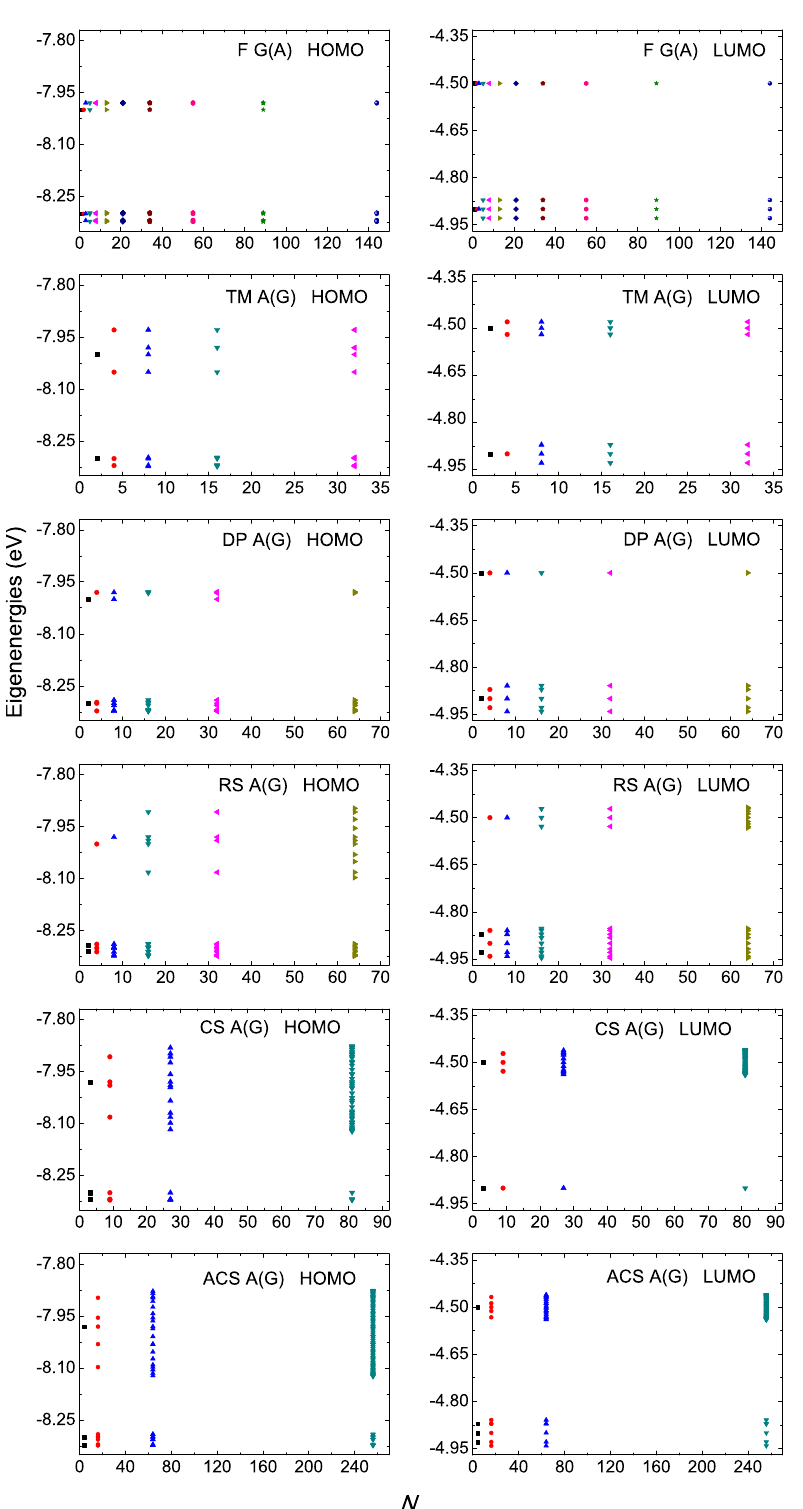
Figure 2. Eigenspectra of F A(G), TM A(G), DP A(G), RS A(G), CS A(G), ACS A(G) polymers, for the HOMO (left column) regime and the LUMO (right column) regime, for a few generations. The horizontal axis shows the number of monomers in the polymer N . Different colors correspond to different generations. The notation of polymers is given in Table